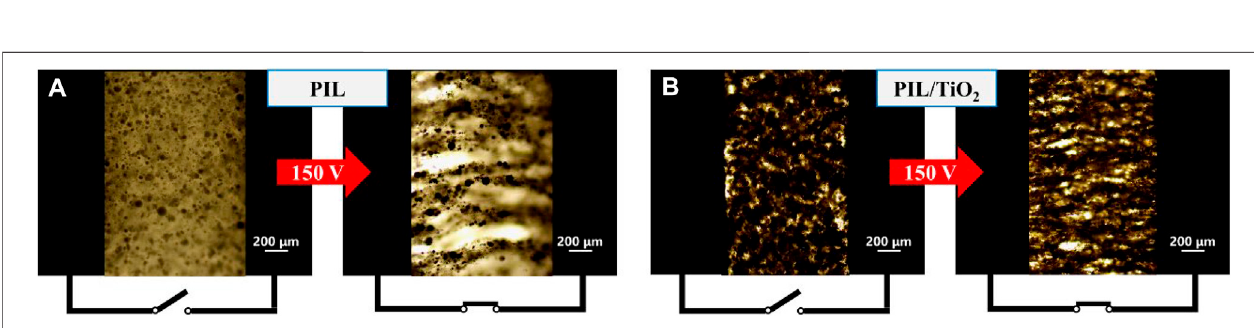
FIGURE 4 | Optical micrograph of the ER fl uids (5 vol%) of PIL (A) and PIL/TiO 2 (B) before and after the application of an electric fi eld (voltage value: 150 V).